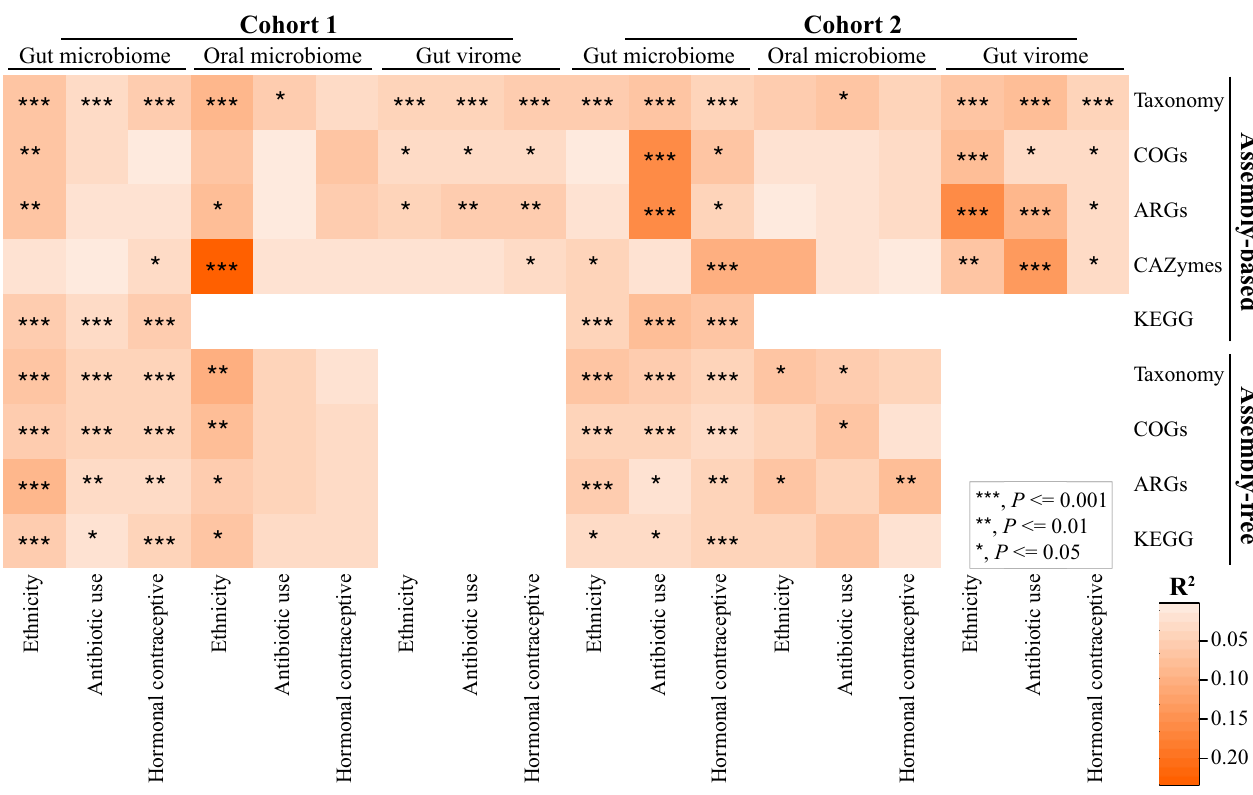
Fig 3. Ethnicity-associated variation in metagenomic communities and functions. The gradient of colors denotes variation explained by the variables, and asterisk symbol indicates p -value of PERMANOVA with Bray–Curtis distance that was performed at all combined dietary stages for taxonomy at the strain level, COGs, ARGs, and CAZymes [peptidoglycanase for virome]. adonis2(data ~ Ethnicity + Antibiotic Use + Hormonal Contraceptive, permutations = perm, method = “bray”, by = “margin”), where perm = with (data, how(nperm = 999, blocks = Day)). See S2 Fig for details of functional categories used for assembly- based PERMANOVA. Data underlying this figure can be found at S1 Data. ARG, antibiotic-resistant gene; CAZymes, carbohydrate active enzymes; COG, cluster of orthologous groups; PERMANOVA, permutational multivariate analysis of variance.